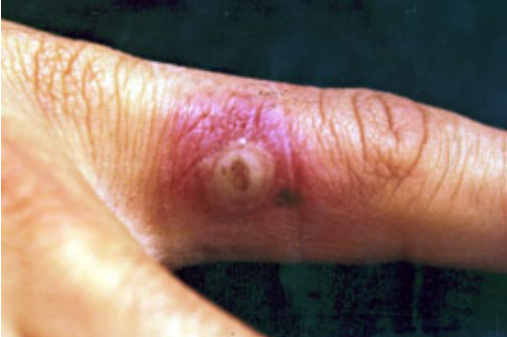
Figure 4: Detail of the lesion showing the erythematous center.